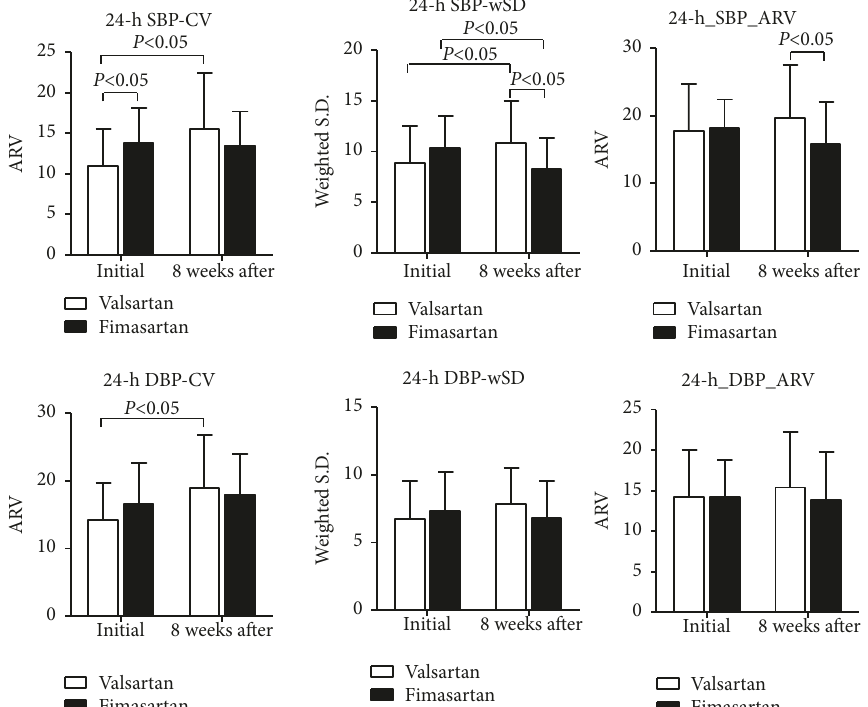
Figure 2: In paired test, while valsartan increased significantly 24-hour CV of systolic and diastolic blood pressure (BP) and 24-hour wSD of systolic BP from the baseline after 8 weeks, fimasartan reduced significantly 24-hour wSD of systolic BP from the baseline after 8 weeks. Comparing with valsartan, fimasartan reduced significantly 24-hour wSD and ARV of systolic BP after 8